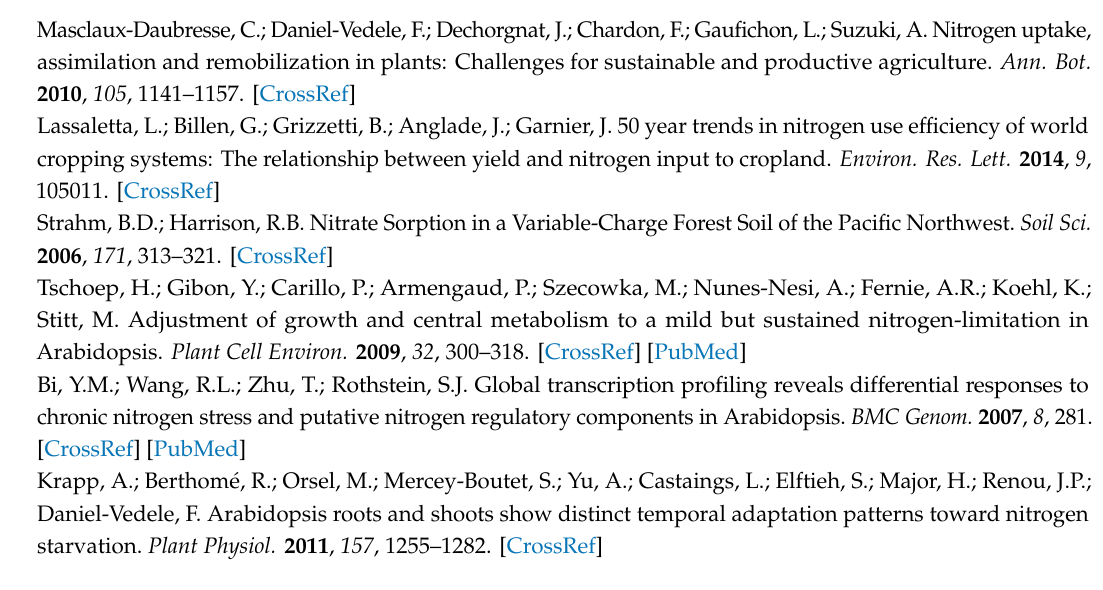
Supplemental Table S1: List of primers used. Supplemental Table S2: Results of qPCR of N metabolism related genes among accessions in two conditions. Supplemental Table S3: Results of qPCR of ATG genes among accessions in two conditions. Supplemental Table S4: Comparison with Publicly Available Microarray Data. Supplemental Figure S1: Relative expression of SAG12 gene in nine accessions grown in the control and N starvation conditions. Blue and red bars are the relative expressions of SAG12 in nine Arabidopsis accessions grown respectively in the control and N starvation